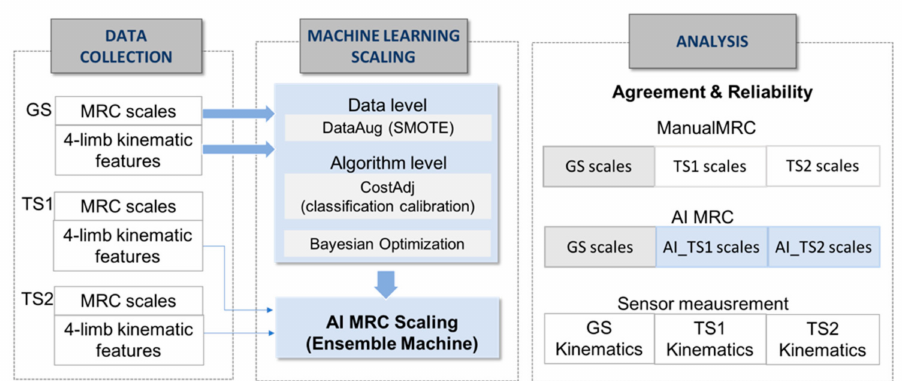
Figure 2. Process of data collection, machine learning-based scaling system and analysis. GS, gold standard; TS1, tester1, TS2, tester2, SMOTE, synthetic minority over-sampling